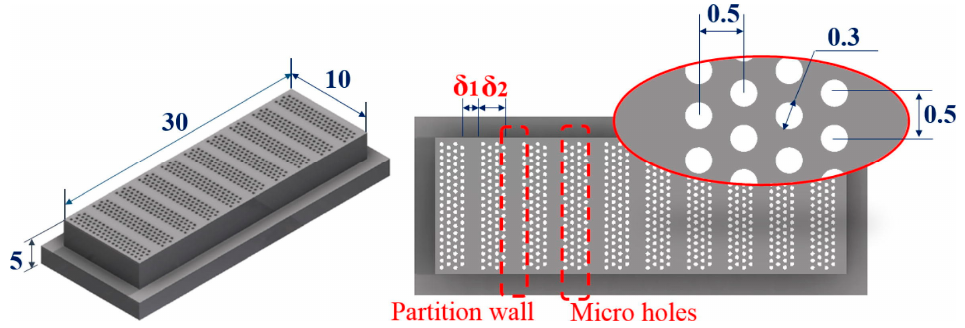
Figure 32. The model of the porous plate with reinforcing partition walls (unit: mm). Reprinted with permission from [126]. Copyright 2018 Elsevier.